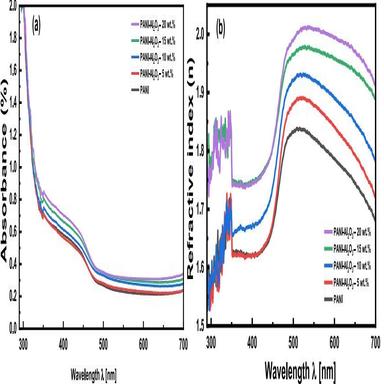
(a) Absorbance and (b) The refractive index (n) of the PANI and PANI-Al2O3 nanocomposite films.